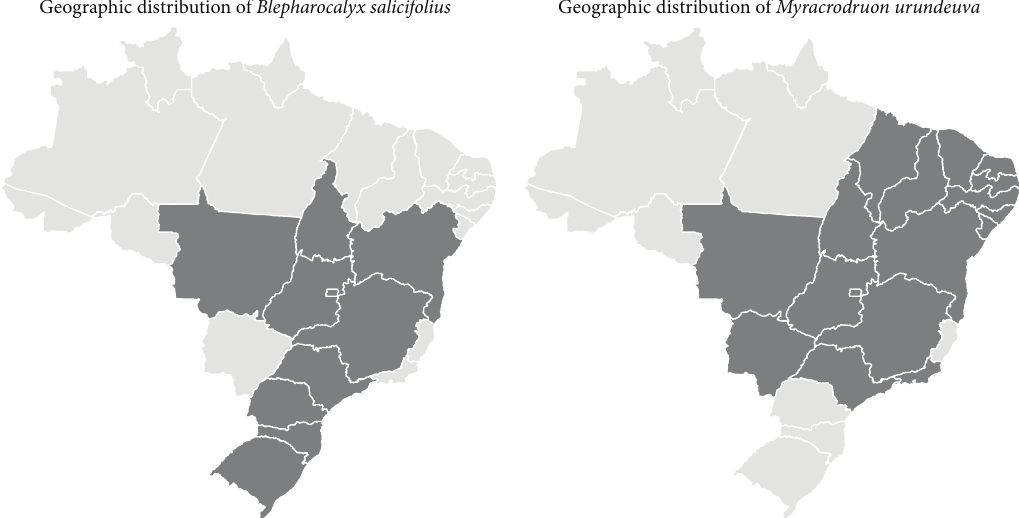
Figure 1: Geographic distribution of Blepharocalyx salicifolius and Myracrodruon urundeuva .